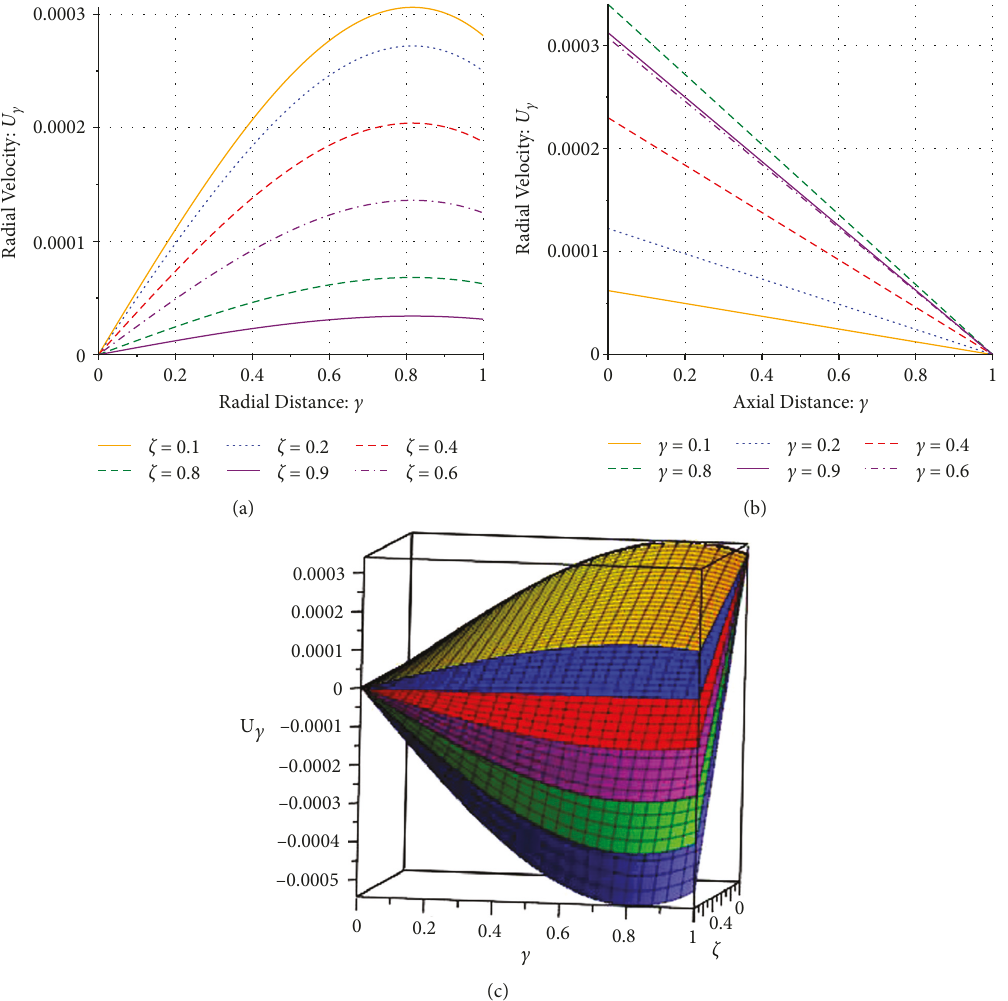
Figure 3: Behavior of radial velocity U W � 0 . 5 × 10 − 5 (a) for S � − 0 . 5 × 10 − 5 , (b) for S � − 0 . 5 × 10 − 5 , and (c) for different values of S , c for 0 S � − 0 . 3 × 10 − 5 (Orange), S � − 0 . 5 × 10 − 5 (Blue), S � − 0 . 7 × 10 − 5 (Red), S � − 0 . 9 × 10 − 5 (Purple), S � − 1 . 1 × 10 − 5 (Green), and S � − 1 . 3 × 10 − 5 (Navy). (a) At different cross-sections. (b) At different c . (c) 3D plot for different values of S